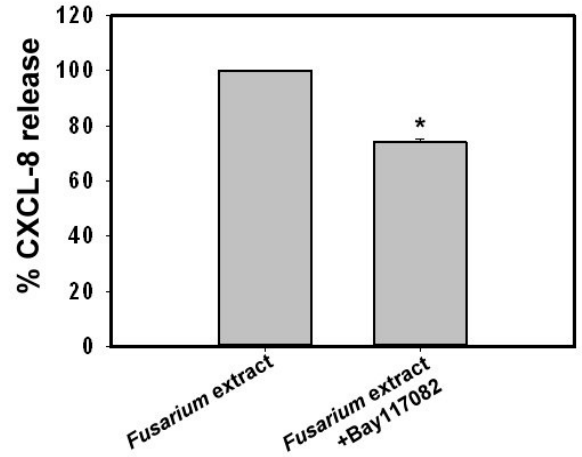
Figure 6. Effect of nuclear factor κ -light-chain-enhancer of activated B cells (NF- κ B) inhibitor on F. proliferatum -stimulated CXCL-8 release. BEAS-2B cells were pre-incubated with BAY117082 (5 µM) for 1 h before treating with F. proliferatum extracts (100 µg/mL) for 24 h. Cultured supernatants were collected and the level of CXCL-8 was determined by ELISA. The results are representative of three independent experiments performed in triplicate. Asterisks (*) indicate significant differences ( p < 0.05) between the paired samples.